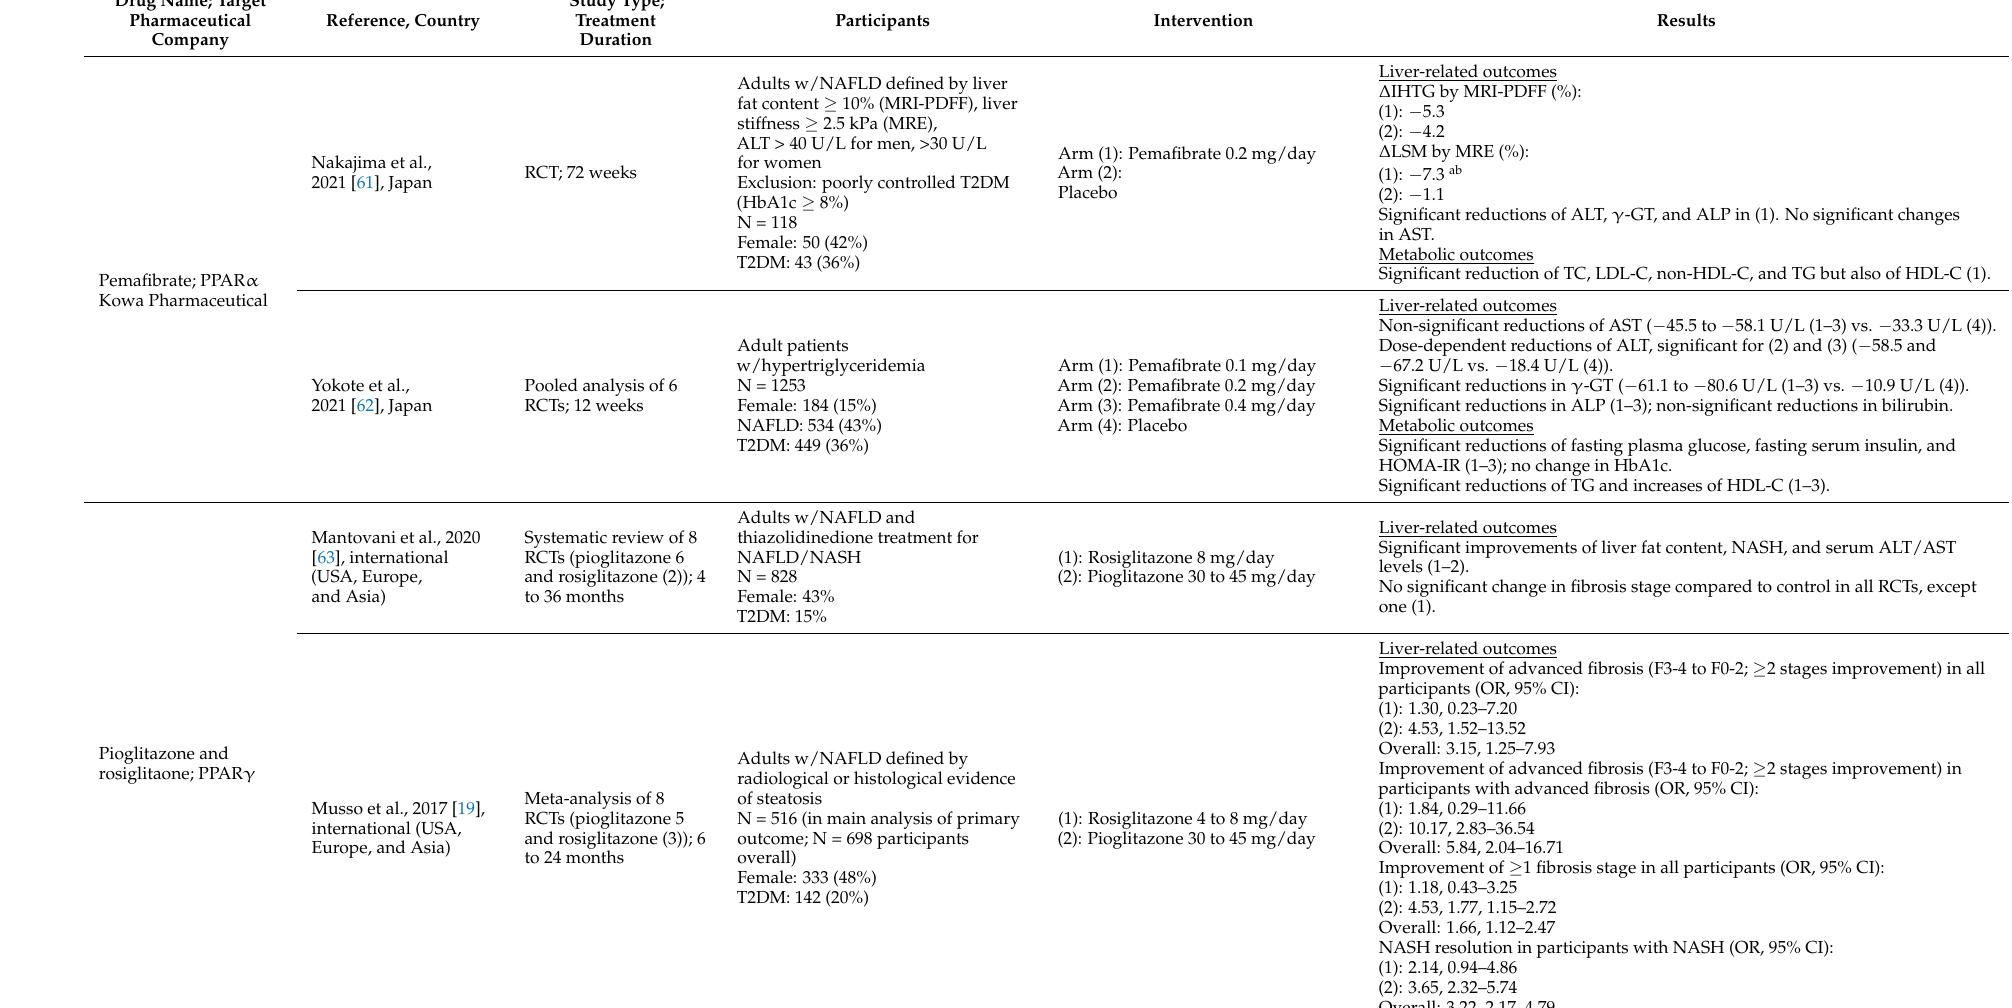
Table 1. Evidence from randomized, controlled trials reporting liver-specific outcomes of PPAR-modulating therapy in NAFLD patients,